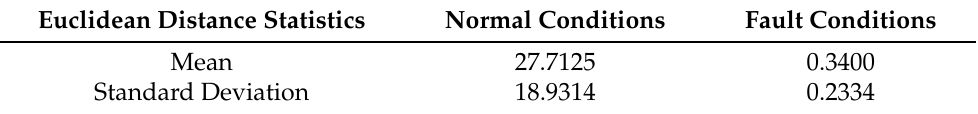
Table 3. 10 Ω fault statistics.